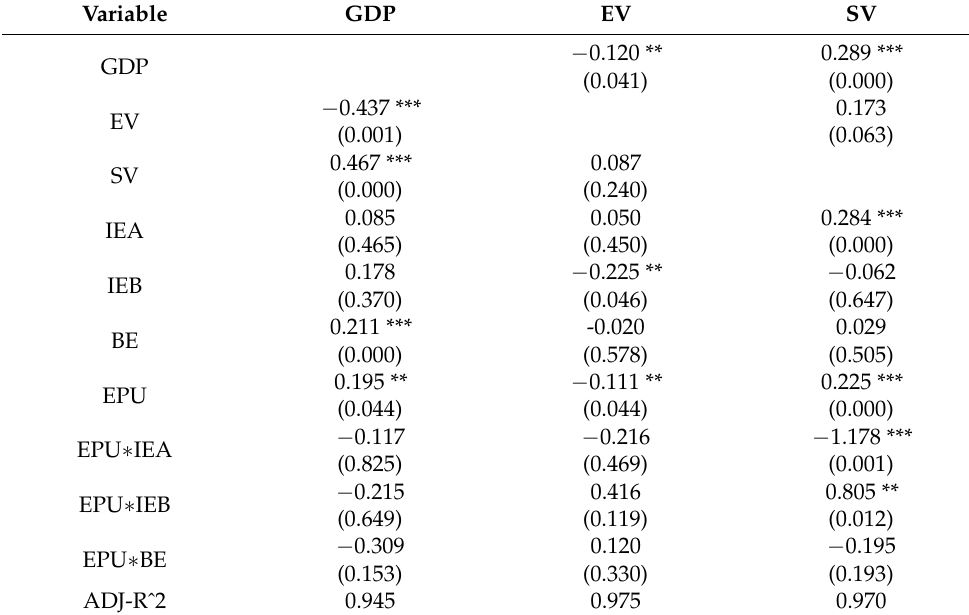
Table 6. Impact of EPU and Entrepreneurship.